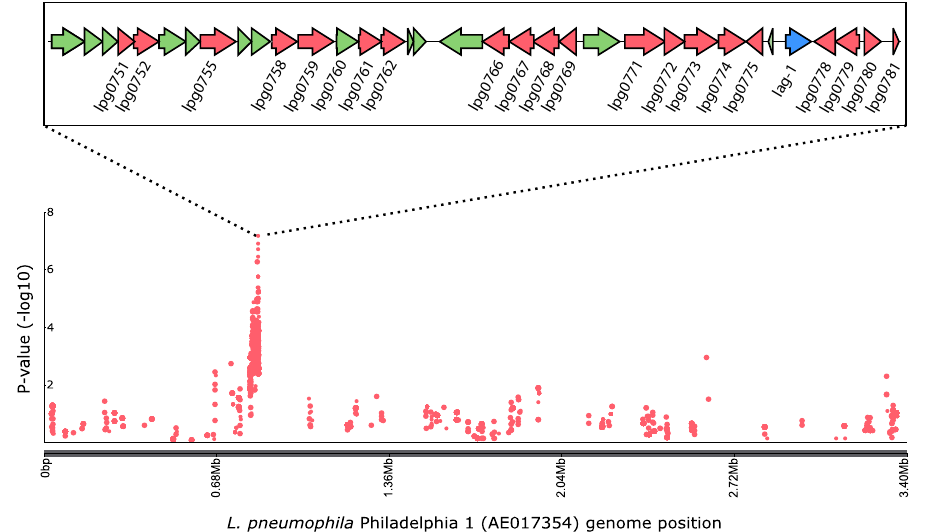
Fig. 2 GWAS reveals gene sequences associated with clinical isolates of L. pneumophila . Manhattan plot showing the genomic position of k -mers signi fi cantly associated with clinical isolates. The LPS biosynthesis and modi fi cation locus (822,150bp – 855,010 bp: lpg0751 - lpg0781 ) in the Philadelphia 1 reference genome (AE017354) [https://www.ncbi.nlm.nih.gov/nuccore/AE017354.1] is represented and genes with signi fi cant k- mer associations coloured in red, with lag-1 in